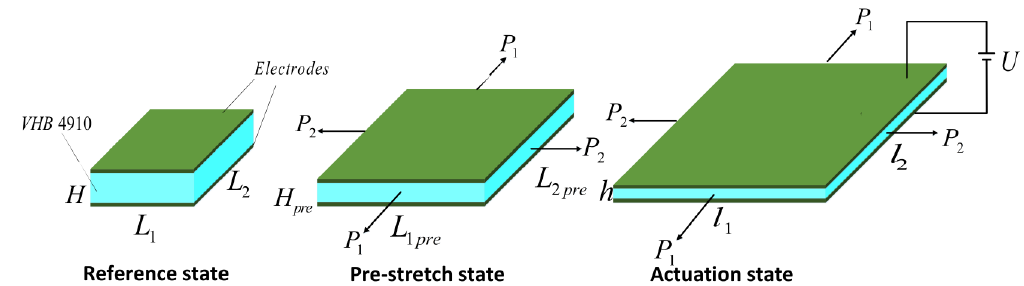
Figure 2. DE membrane in the reference state, pre-stretch state, and actuation state.